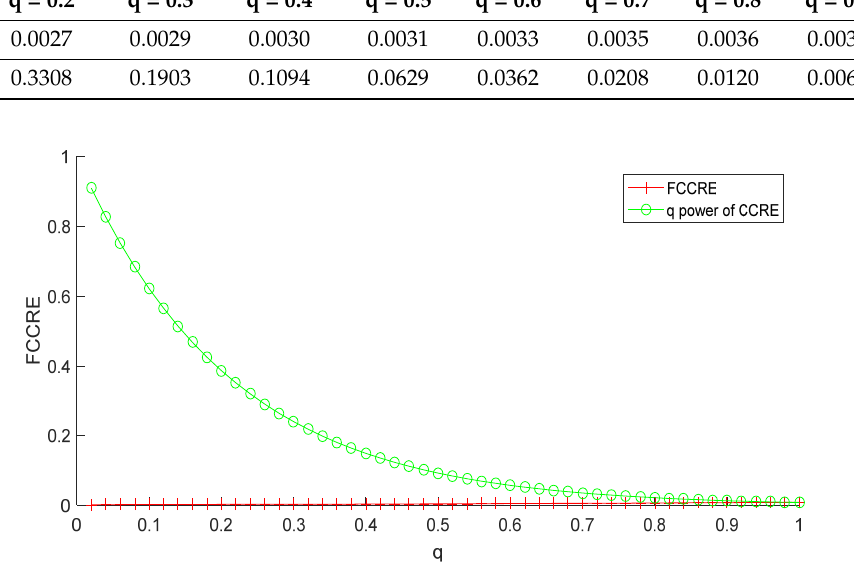
Figure 10. The fractional conditional cumulative residual entropy of ε q ( U | η ) and the q power of conditional cumulative residual entropy of [ ε ( U | η )] q